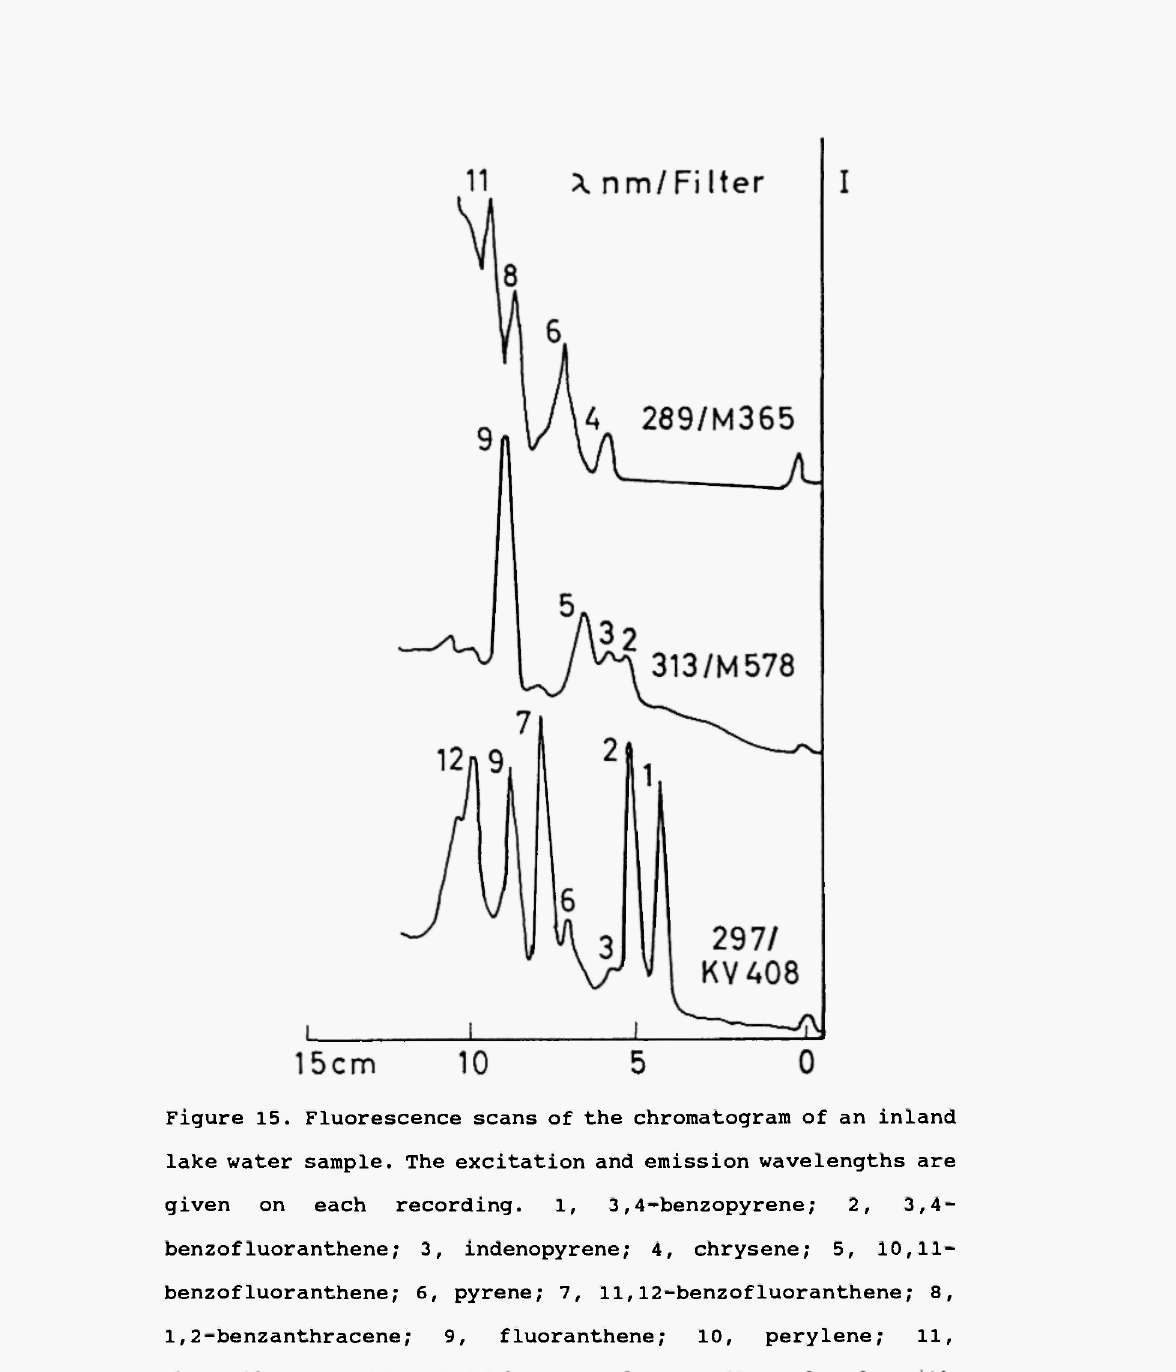
Figure 15. Fluorescence scans of the chromatogram of an inland lake water sample. The excitation and emission wavelengths are given